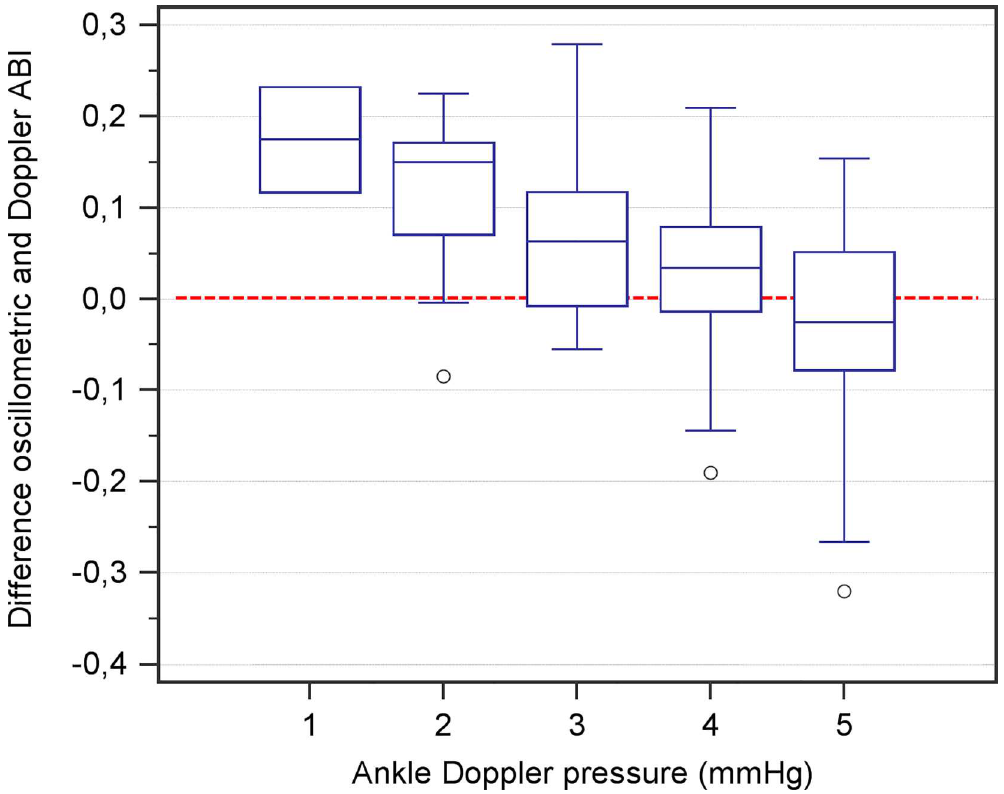
Fig 3. Box plots of the differences between methods in ABI according to ankle pressure. Differences betweenoscillometric and DopplerABI values (Y axis) are plotted as a function of the ankle pressure in mmHg measuredby Doppler(X axis). Measurements are dividedin 5 groups accordingto ankle pressure (mmHg) in intervalsof 20 mmHg: 1 (70–89mmHg), 2 (90–109mmHg), 3 (110–129mmHg), 4 (130–149mmHg) and 5 ( > 150